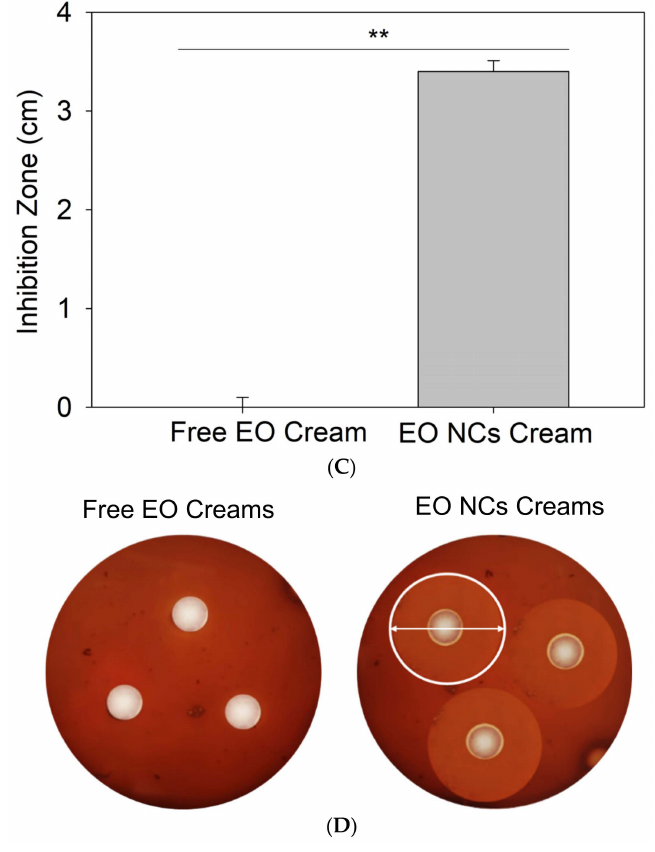
Figure 3. ( A ) Antibacterial activity of non-encapsulated and encapsulated EO against C. acnes. ( B ) Time-kill curves, ( C ) zone of inhibition (cm) of C. acnes growth by the free EO or EO-loaded NC anti-acne creams, and ( D ) agar plates inoculated with C. acnes and the free EO or EO-loaded NC anti-acne creams. All experiments were performed in triplicate, and the data are expressed as the mean ± standard deviation. ** stands for p < 0.05, considered statistically